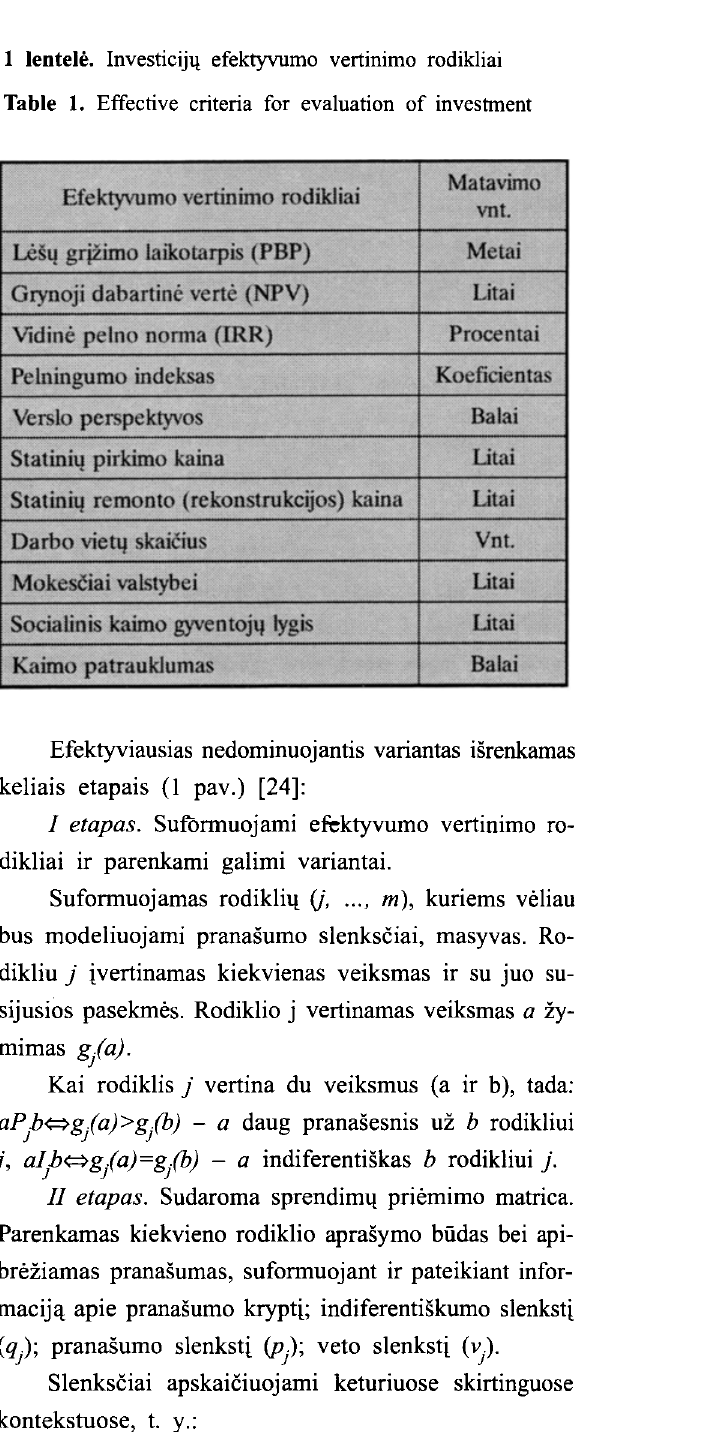
Table 1. Effective criteria for evaluation of